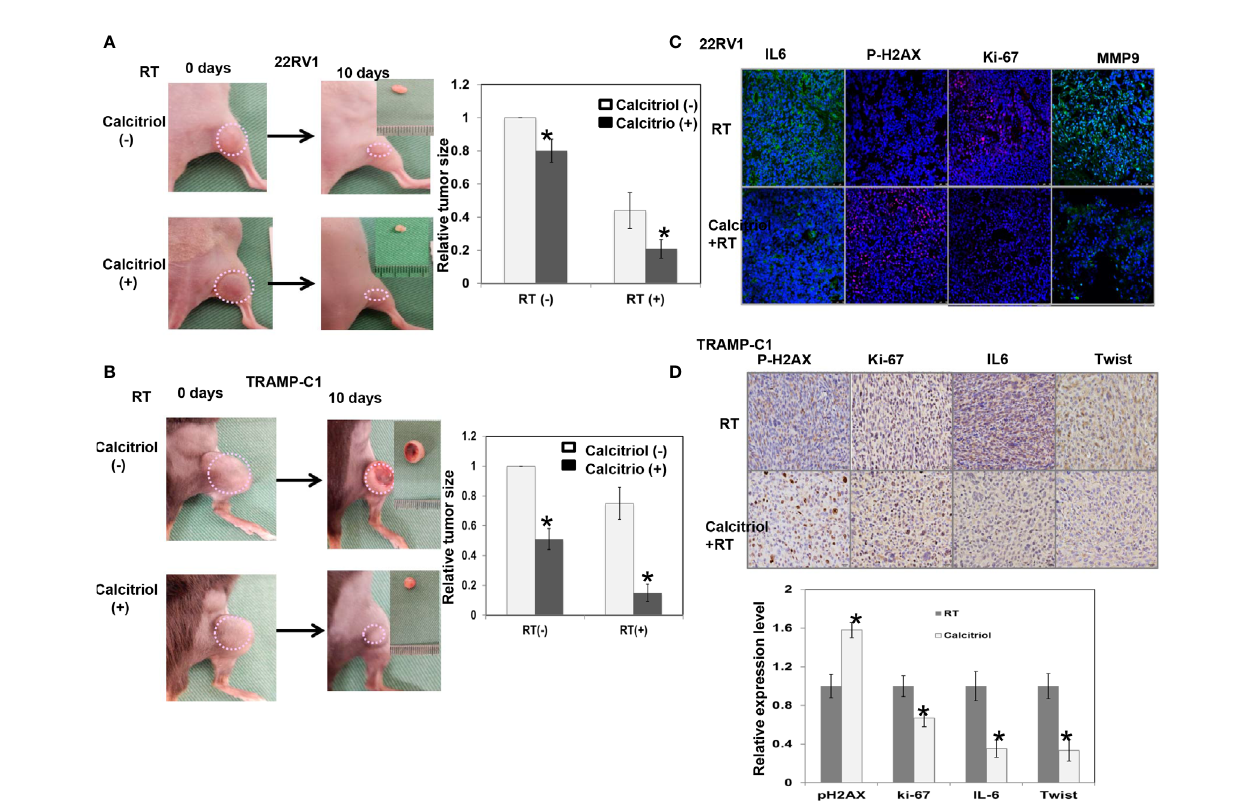
FIGURE 5 | Effects of calcitriol on the radiation sensitivity in vivo . (A) The effect of calcitriol on the radiosensitivity of prostate cancer (22RV1) in immunocompromised mice, and (B) prostate cancer (TRAMP-C1) in immunocompetent mice, as demonstrated by relative tumor size of the ectopic tumor. Representative images and quantitative data are shown indicated days after 15 Gy radiotherapy (RT). The y axis represents the relative ratio, normalized to the tumor size of 22RV1 and TRAMP-C1 tumors under sham irradiation, respectively. (C) The effect of calcitriol on tumor after irradiation is demonstrated by immuno fl uorescence using IL-6, Ki-67, MMP-9, and p-H2AX staining in 22RV1 tumor (DAPI, blue; Ki-67/p-H2AX, red; IL-6/MMP-9, green), and (D) IHC using IL-6, Ki-67, Twist, and p-H2AX staining in TRAMP-C1 tumor. Representative images are shown. The quanti fi cation is to calculate the value of the cell number positive for targeted protein divided by the total cell number. The Y-axis represents the ratio normalized by the value of irradiated tumor without calcitriol treatment. *p <